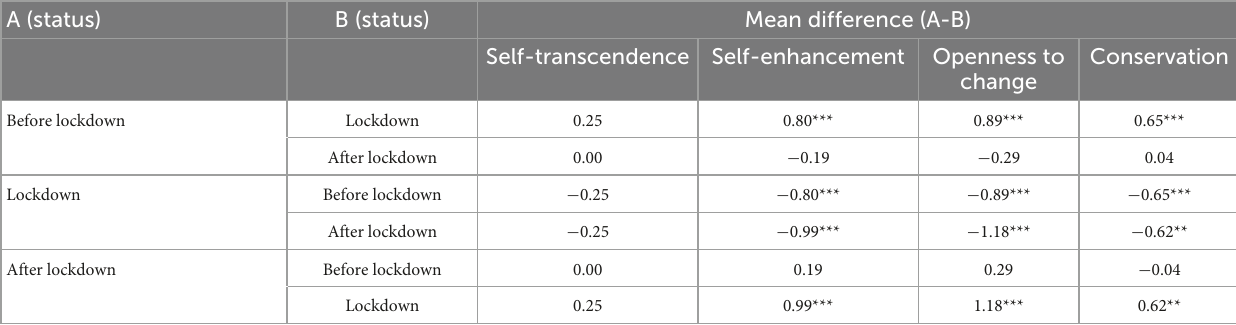
TABLE 3 Mean differences and post hoc results for individual-level higher-order dimensions of personal values before the lockdown, during the lockdown, and after the lockdown a . A